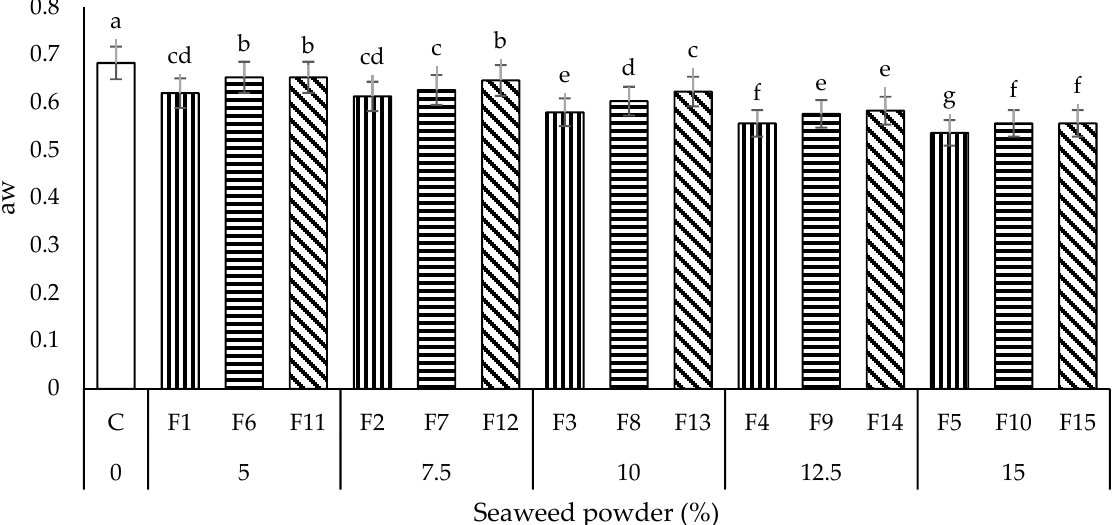
Figure 6. Water activity measurement (a w ) of all the noodles samples. Data are presented as mean ± standard deviation ( n =3). a–g with different superscripts indicate the significant difference among the noodles samples (Tukey’s HSD, p < 0.05). Bars with vertical, horizontal, and diagonal patterns = wheat flour: potato starch ratios of 9:1, 8:2, and 7:3, respectively.